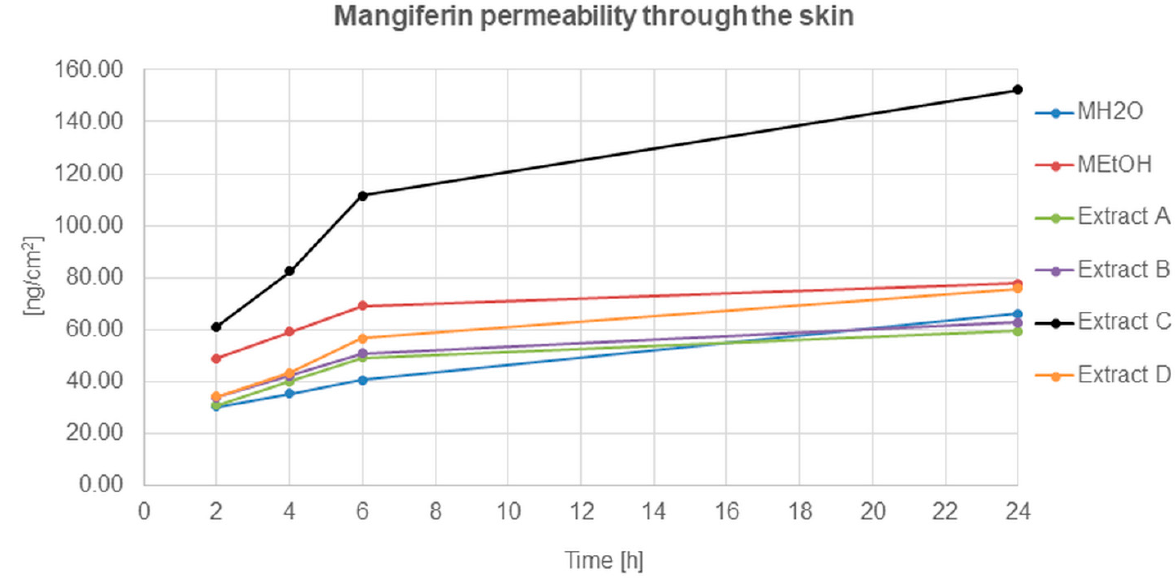
Figure 5. Mangiferin permeation through the skin after 2, 4, 6, and 24 h (ng/cm 2 ) from the application of mangiferin solutions: water (MH 2 O, 25 µ g/mL), ethanol (MEtOH, 25 µ g/mL, 50% ( v/v )), or honeybush extracts: A, B, C, D.